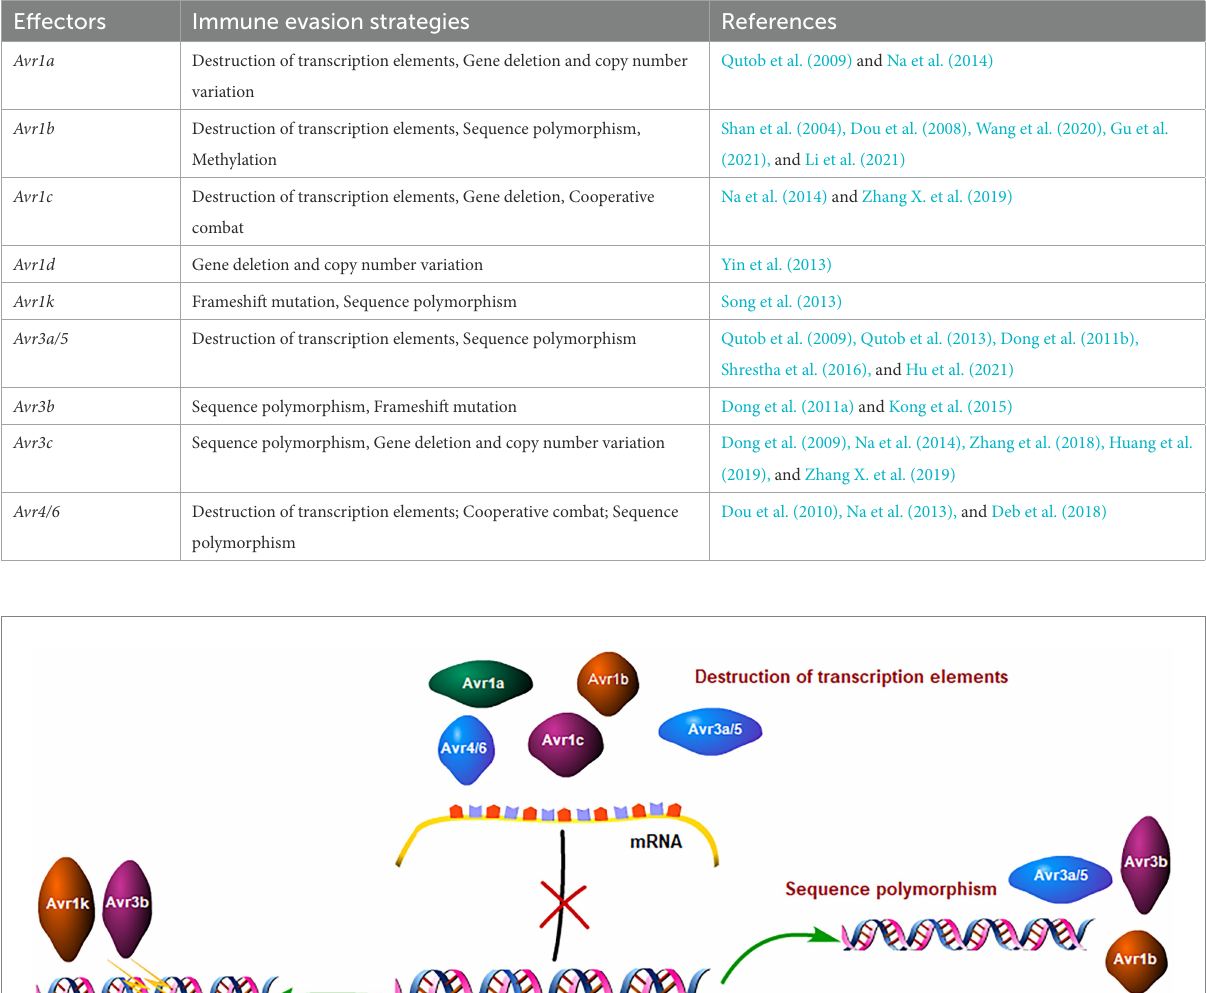
TABLE 1 Immune evasion strategies of Phytophthora sojae Avr genes.